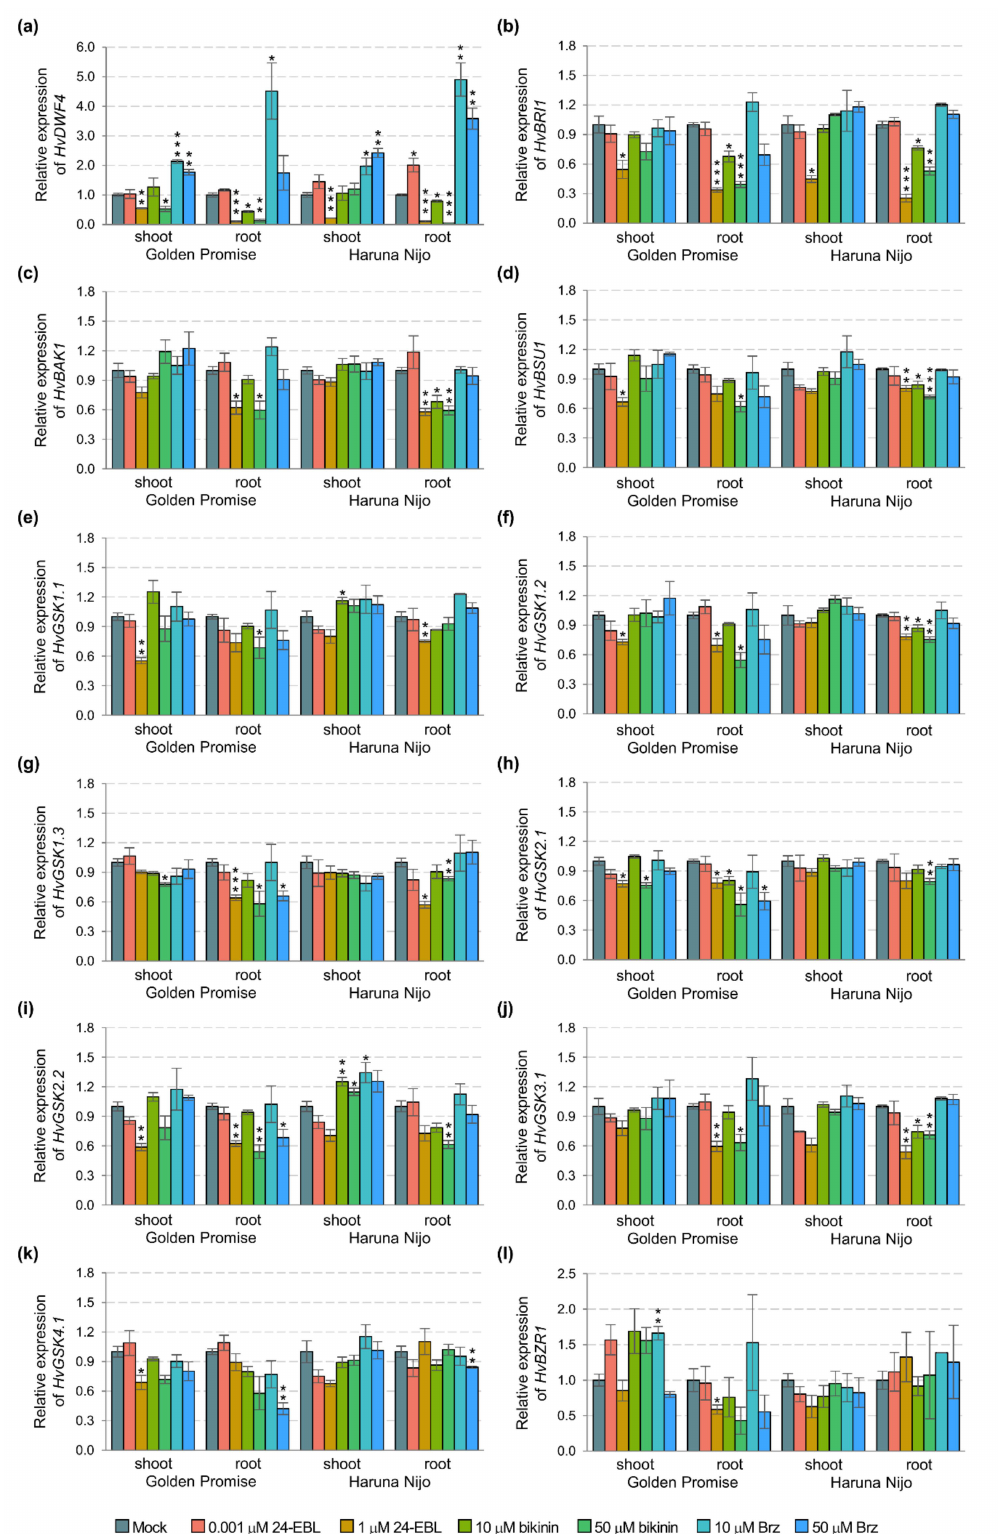
Figure 3. Expression profiles of the genes encoding enzymes of BR biosynthesis and signaling pathways in two barley cultivars Golden Promise and Haruna Nijo. Shoots and roots were treated with 24-EBL (0.001 and 1 µ M), bikinin (10 and 50 µ M), and Brz (10 and 50 µ M), mock represents the plants treated with the respective solvent solutions, i.e., EtOH and DMSO assumed as 1.00. The results present the mean with a standard error ( n = 3). The asterisks indicate significant differences, revealed by the Student’s t -test for p < 0.05 (*), p < 0.01 (**), and p < 0.001